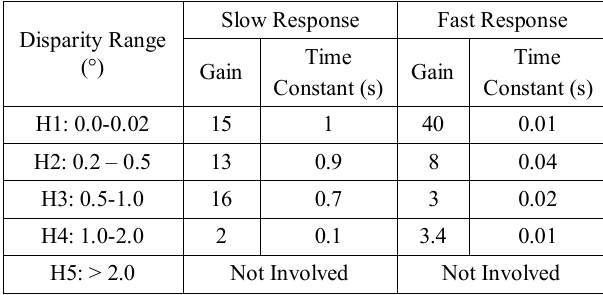
Table 7. Parameters in switched-channel model used to attain a better fit for the experimental 2 